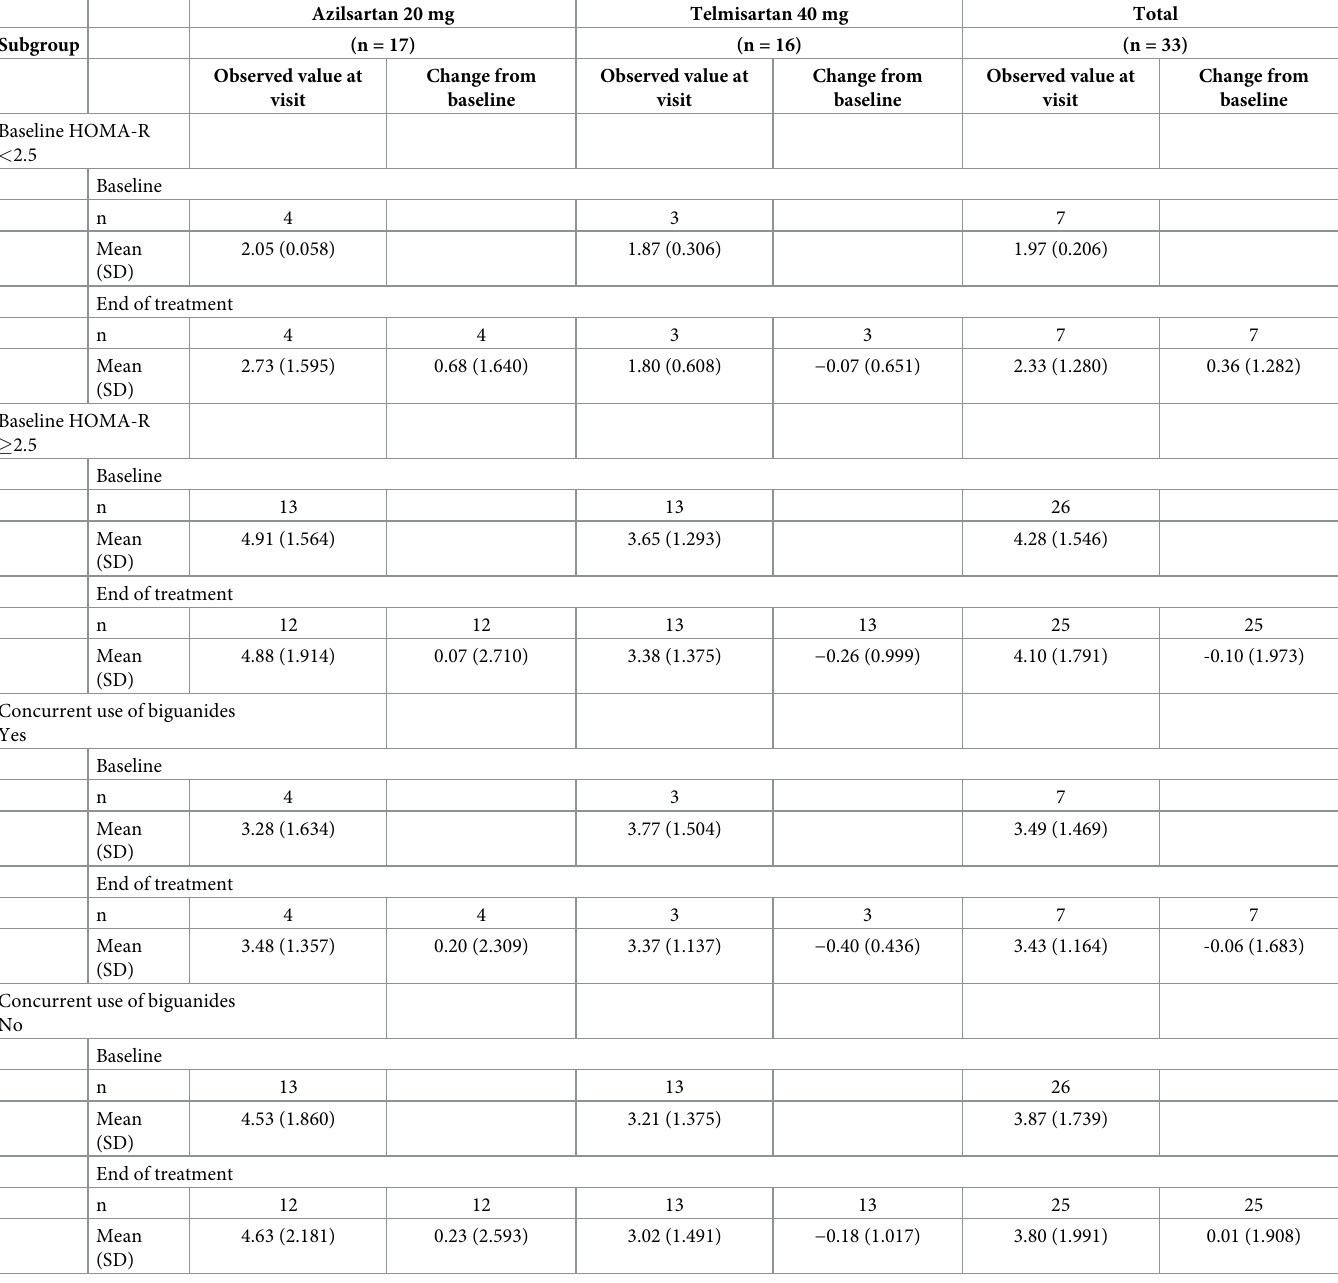
Table 3. Changes from the baseline values in HOMA-R at the end of the treatment period by subgroup (FAS). Azilsartan 20 mg Telmisartan 40 mg Total Subgroup (n = 17) (n = 16) (n = 33) Change from Observed value at Change from Observed value at Change from Observed value at visit baseline visit baseline visit baseline Baseline HOMA-R <